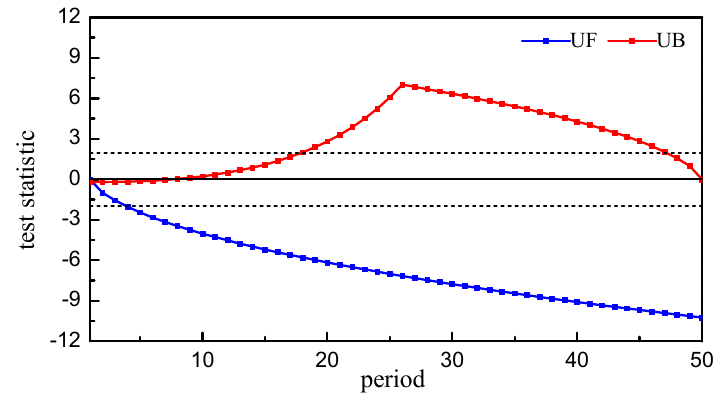
Figure 4. Detection result of Mann–Kendall test on single mutation point series without errors.